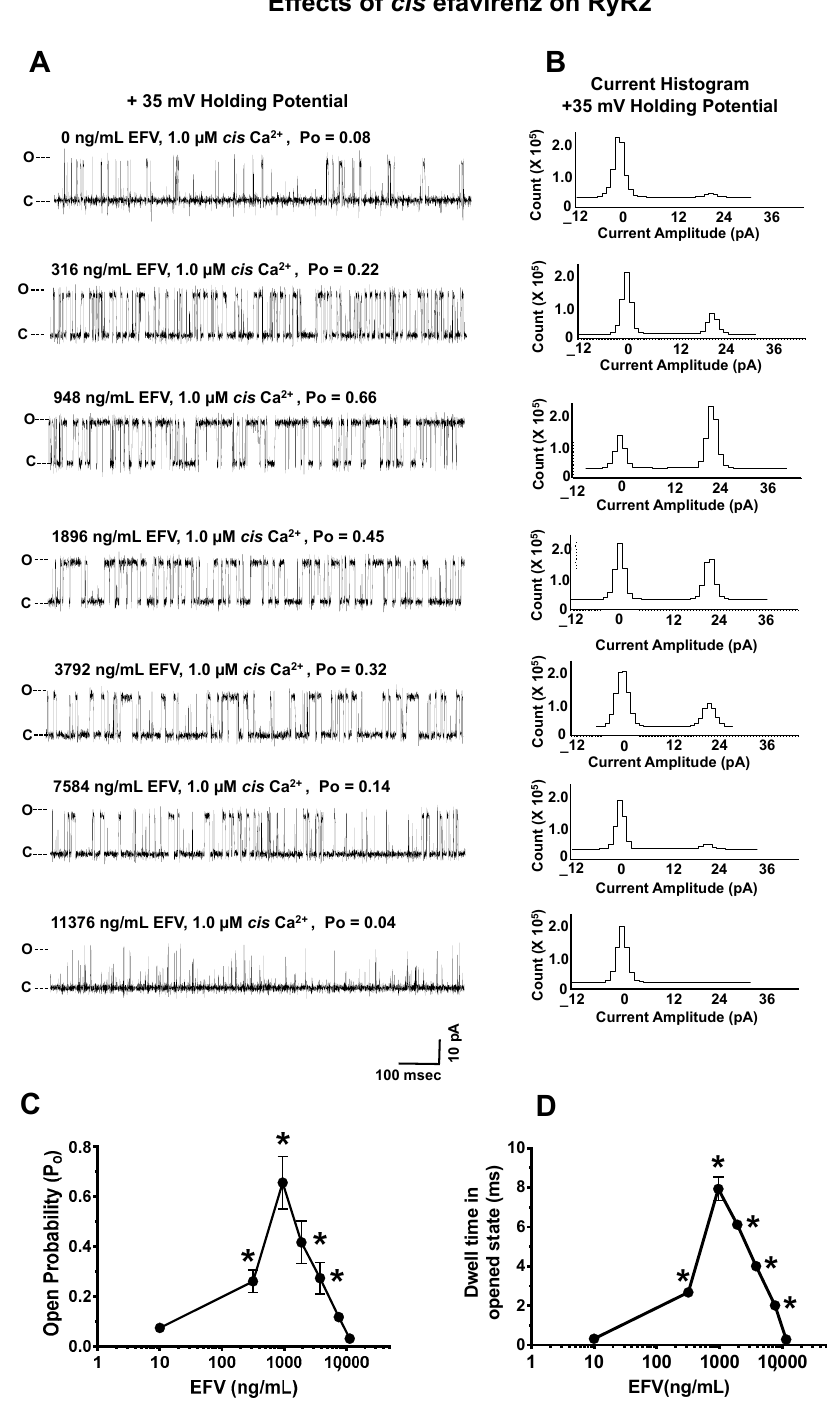
Figure 4. Effects of increasing cis concentrations of efavirenz (EFV) on the open probability of RyR2. Panel A shows a representative 1.0 s recording of a RyR2 channel with 1.0 µ M cis Ca 2+ and cumulative amounts of cis EFV. Panel B shows the current histograms for the channel with cumulative amounts of cis EFV. Panels C,D are graphs of the open probability and dwell time (mean ± SD) of RyR2 as a function of the cis concentrations of the EFV channels for n = 12 channels. Recordings shown are at +35 mV (upward deflections) in a symmetric KCl buffer solution (0.25 mM KCl; 20 mM K/HEPES; pH 7.4). O, open; C, closed. * denotes significantly different ( p < 0.05) from the control (before the addition of the